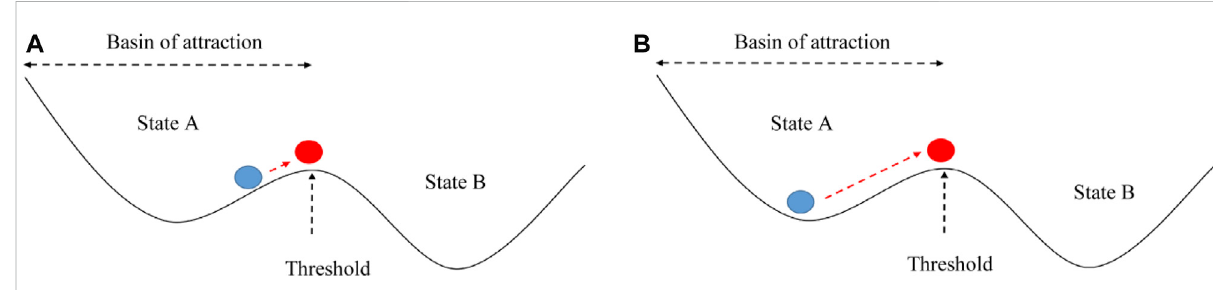
FIGURE 11 Schematic diagram of the CSD phenomenon (Dakos et al., 2015). (A) close to the threshold and (B) far from the threshold.